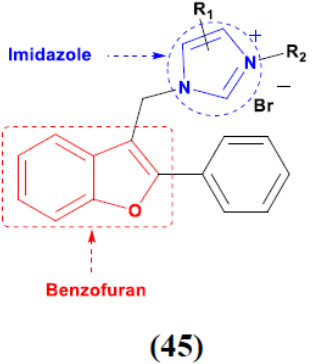
Figure 51. Structure of imidazole based benzofuran hybrid derivatives ( 45 ).